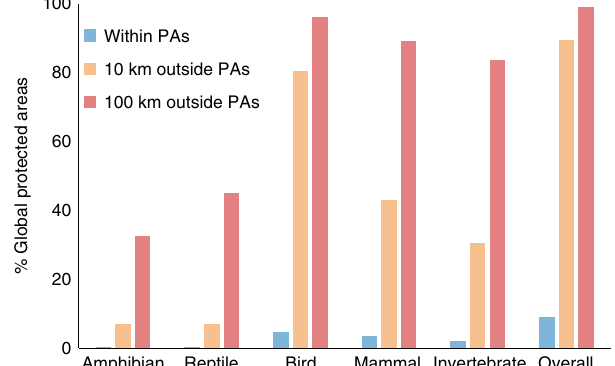
Fig. 2 Proportion of global terrestrial PAs and the surrounding areas (10 and 100 km distance to PA boundaries) colonized by different taxonomic groups. We designated PAs as invaded when at least one animal species has established an alien population therein, and also quanti fi ed the proportion of uninvaded PAs with at least one animal species with an established population within 10 and 100 km of the PA